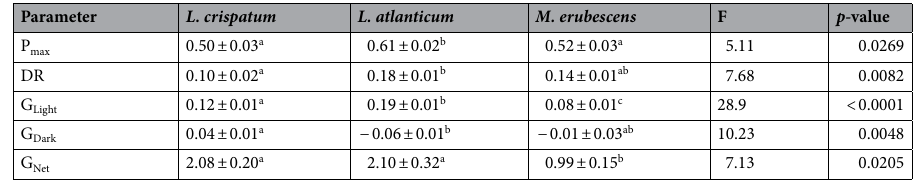
Table 2. Metabolic and calcification rates of different rhodolith species under saturating light conditions, normalized by surface area (P max - maximum gross photosynthesis and DR- dark respiration, in µmol O 2 cm -2 h -1 ; G Light and G Dark - light and dark calcification, in µmol CaCO 3 cm -2 h -1 ; G Net – daily net calcification, in µmol CaCO 3 cm -2 day -1 , considering 14 h light:10 h dark). Data shown are mean ± SE (n = 5 per species). Statistical results of one-way ANOVAs, testing for differences between species, are given and indicated by superscript letters (Newman-Keuls post-hoc).